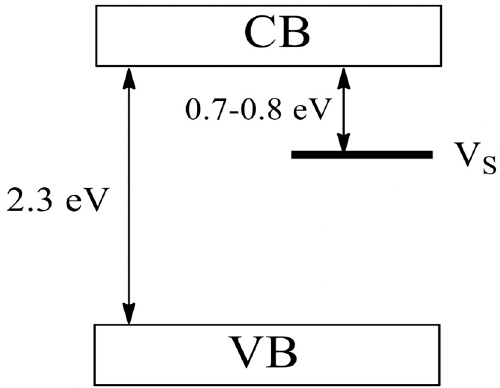
Scheme 2. Schematic energy level diagram for CdS-HTa400.